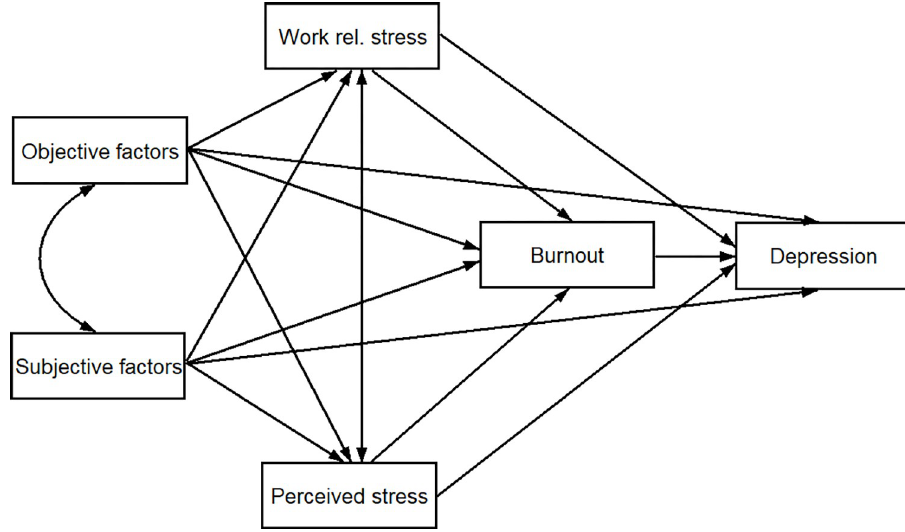
Fig 1. Hypothetical model of COVID-19 related factors’ possible effects on mental